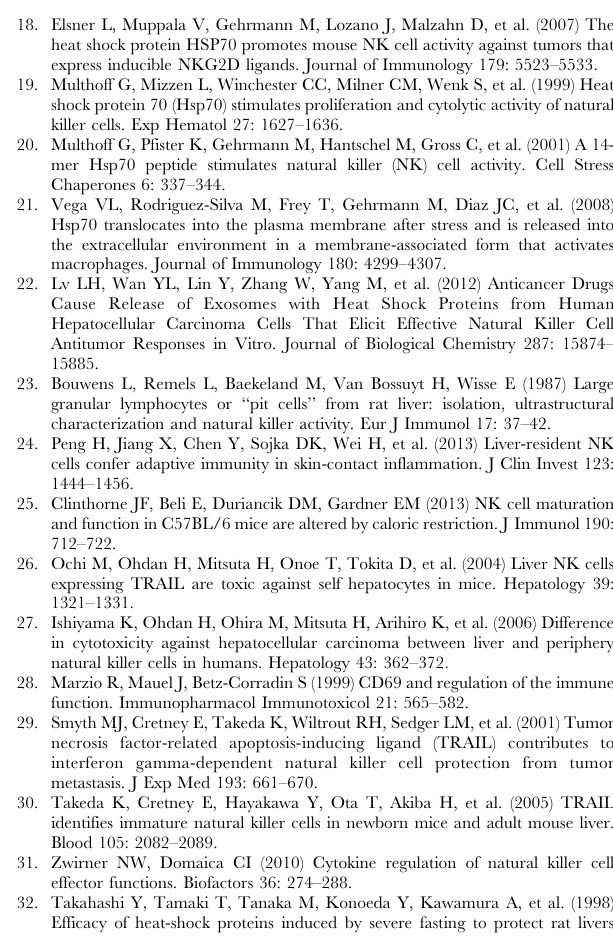
Figure S1 Additional phenotypic analysis of natural killer cells from the spleen, bone marrow, and blood under starvation. (A) The mean proportion plus standard deviation of gated TCR b 2 NK1.1 + natural killer (NK) cells from the liver, spleen, bone marrow, and blood of fed and 3-day-fasted mice are shown in bar graphs. (B) Histograms show the representative expression of the indicated markers on NK cells (solid lines) with the percentages of positive NK cells from the spleen, (D) bone marrow, and (F) blood; dotted lines represent negative control. Bar graphs represent the mean percentage plus standard deviation of positive NK cells in (C) the spleen, (E) bone